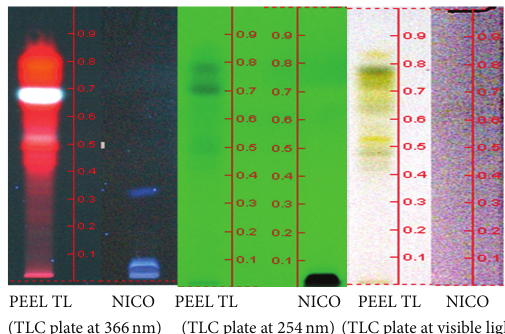
Figure 3: General HPTLC finger print profile of nicotine standard (NICO) with petroleum ether leaf extract of T. leucostaphylum (PEELTL) at wavelength 254 nm, 366 nm and visible